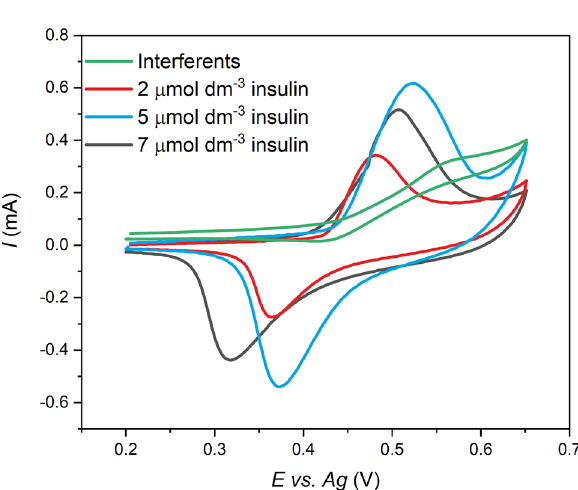
Figure 9. CV measurements used for the evaluation of reproducibility of Ni-c-ITO electrodes using 2 × 10 –6 mol dm −3 in 0.1 mol dm −3 NaOH and PBS at 50 mV s −1 ( A ). The fabrication reproducibility of Ni-c-ITO in the different toward 2 × 10 –6 mol dm −3 in 0.1 mol dm −3 NaOH and PBS at 50 mV s −1 ( B ).